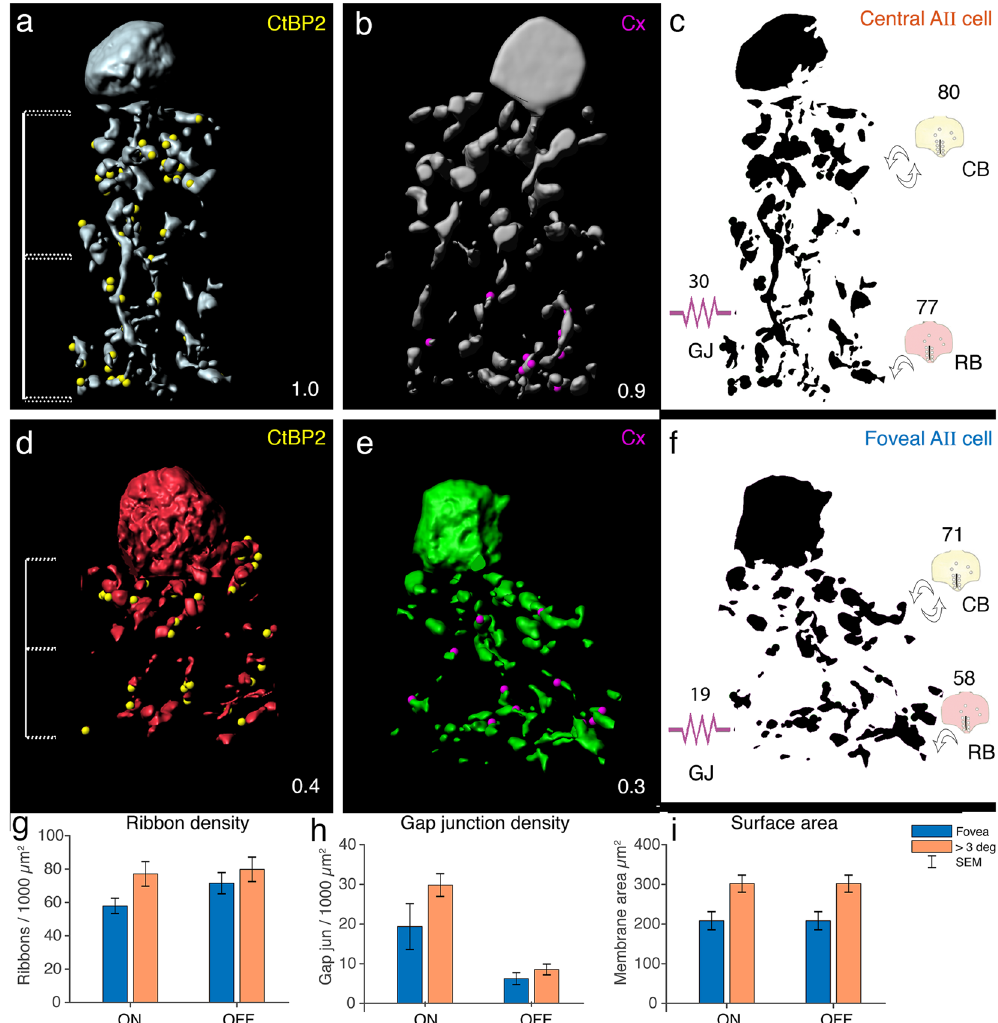
Figure 7. Comparison of AII cells in foveal and central retina. ( a,b,d,e ) Three dimensional reconstructions of AII cells from central and foveal retina together with synaptic ribbons (yellow) and gap junctions (magenta) summarizing our findings. Numbers in the bottom right represent eccentricities in mm. ( c,f ) Schematic drawings of the distribution of CtBP2 immunoreactive puncta (symbolized as ribbons in bipolar ending) and Cx36 immunoreactive puncta (symbolized as electrical resistor). The values represent the average number of immunoreactive puncta per 1000 µ m 2 dendritic surface area of reconstructed AII dendrites. ( g–i ) Histograms of ribbon density, gap junction density and surface area of reconstructed AII cells as function of retinal eccentricity and laminar position. CB, cone bipolar; RB, rod bipolar, GJ, gap